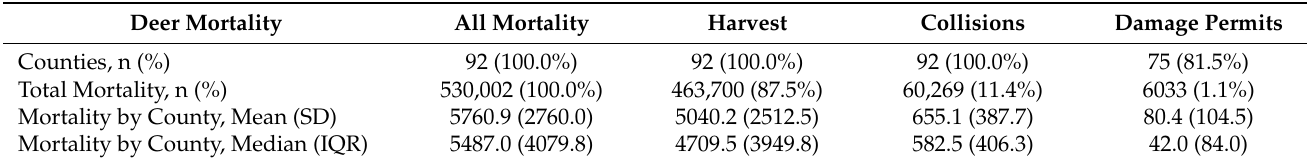
Table 4. Summary statistics of deer mortality across 2017–2020 as reported by the IDNR. Deer mortality can be attributed to three main causes: killed under a hunting permit (“harvested”),